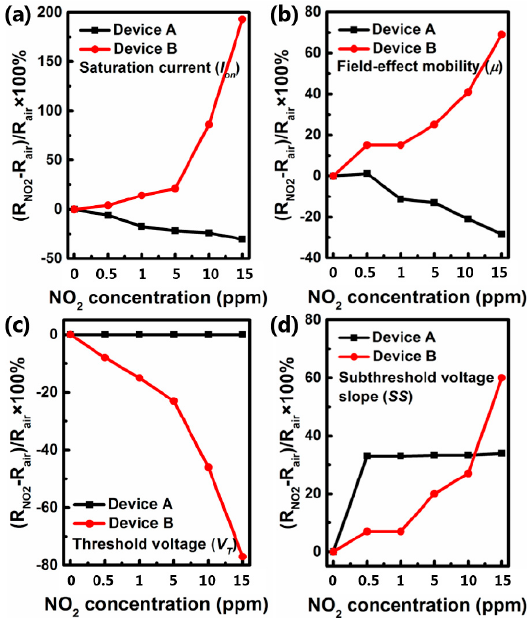
Figure 4. Percentage variation of I on ( a ), µ ( b ), V T ( c ) and SS ( d ) of all the devices at different NO 2 concentrations, respectively.